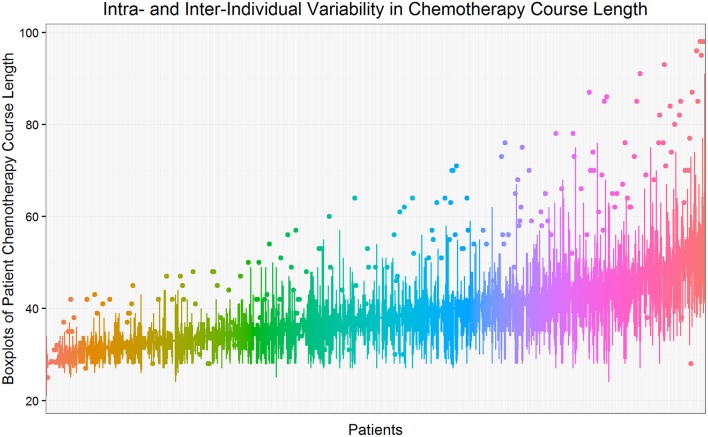
Intra- and inter-individual variability in chemotherapy course length. Each line represents a patient's median and interquartile range (IQR), sorted from the lowest to the highest median value. The overall median chemotherapy course length is 36 days (IQR 32–42 days). Course length observations less than −1.5*IQR below 25th percentile or more than 1.5*IQR above the 75th percentile are considered to be outliers and are shown as isolated points.